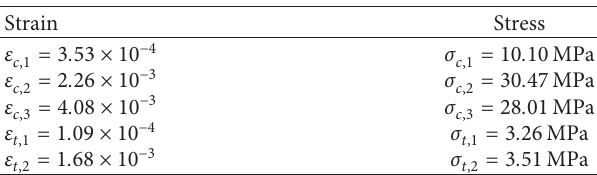
Table 3: Simplified model parameters of the reinforced concrete simply supported